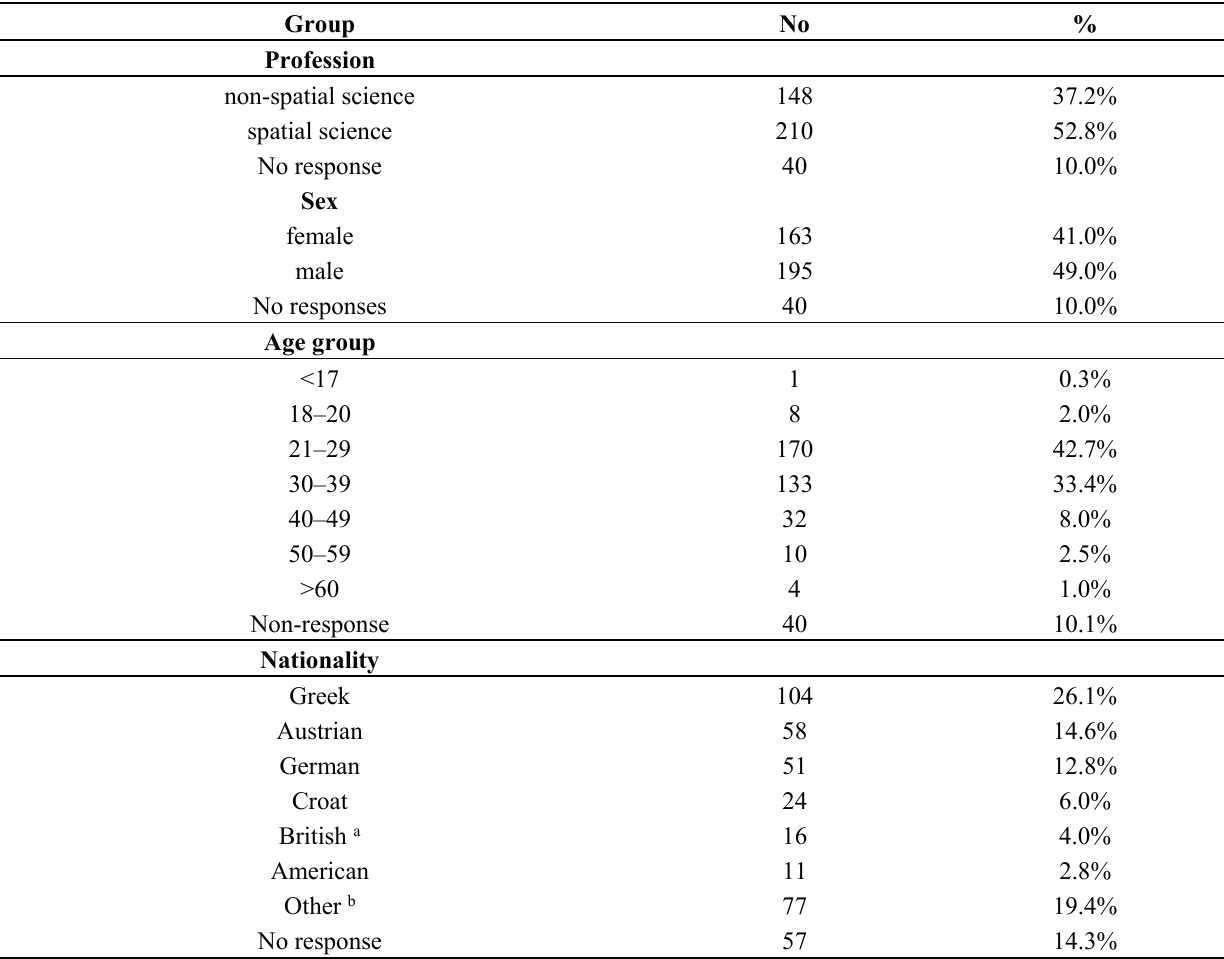
Table 1. Characteristics of participants (No = 398). a Nationalities in the U.K. are aggregated to “British” citizenship, since participants used different wording to describe their nationality; b nationalities with less than 10 participants per nationality (in total, 36 nationalities).